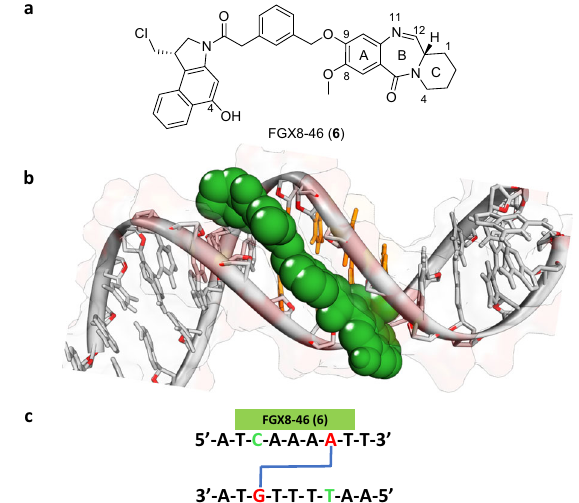
Fig. 2 Structure and DNA interaction of the G-A cross-linking ADC payload FGX8-46. a Structure of the G-A cross-linking ADC payload FGX8-46 ( 6 ). b Low energy snapshot of a Molecular Dynamics Simulation of 6 binding in the DNA minor groove, with the molecule spanning the seven base-pair sequence 5 ′ -T-C(G)AAAA-T-3 ′ . c Details of the sequence spanned in the molecular model (covalently-bound bases in